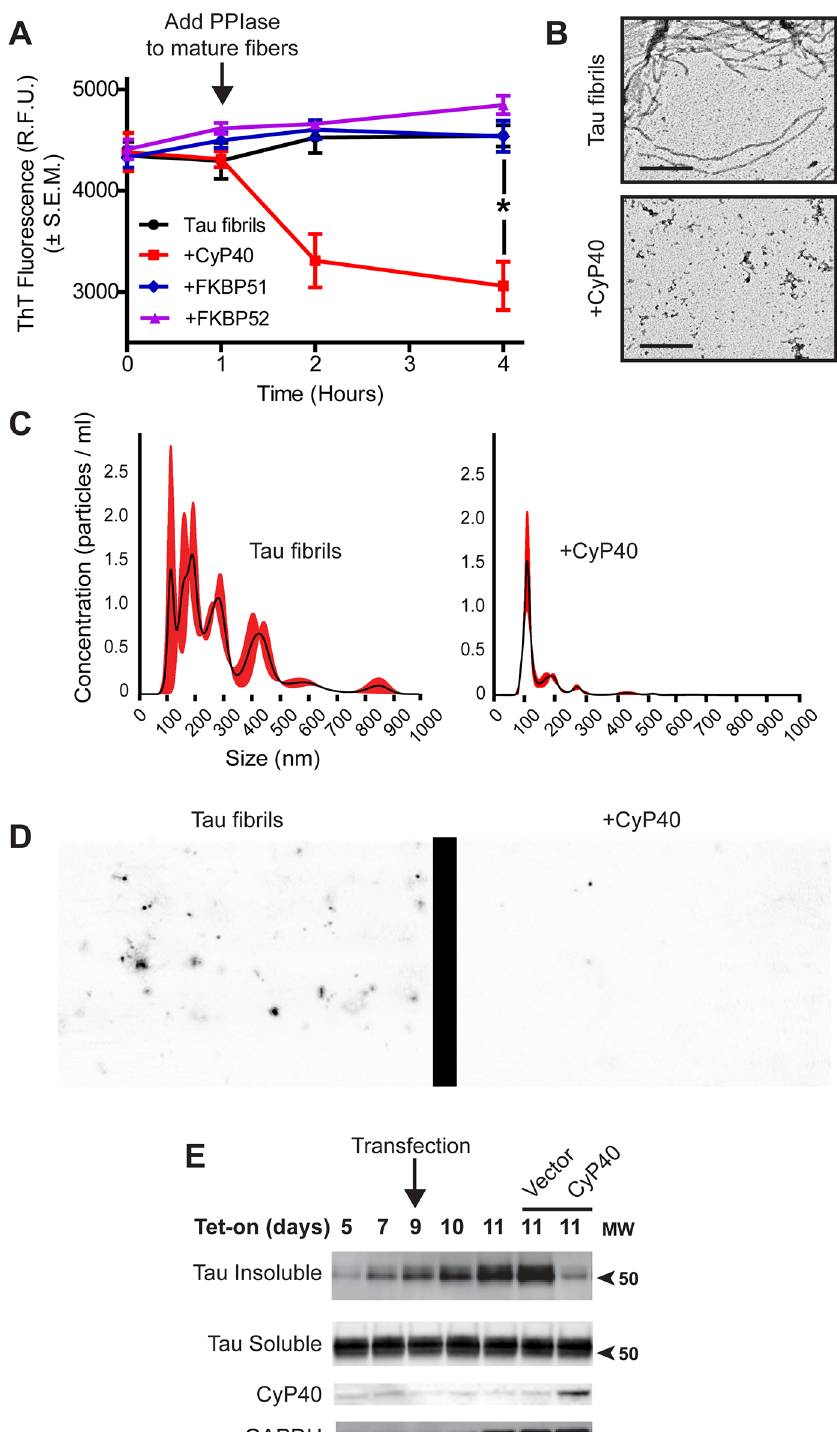
Fig 1. Cyclophilin 40 (CyP40) disaggregated tau fibrils. (A) Preformed tau fibrils were monitored for thioflavinT (ThT) fluorescence intensity over 4 hours. CyP40, FK-506 bindingprotein (FKBP) 51, and FKBP52 were added at 1 hour, and monitoring continuedfor 3 hours (bars represent standarderror of the mean [SEM], unpaired t test, p = 0.0048, n = 3 independentprotein preparations). (B) Representative 60,000 × transmission electron microscopy (TEM) images of tau fibrils or CyP40-treated fibrils (scale bar 400 nm, n =